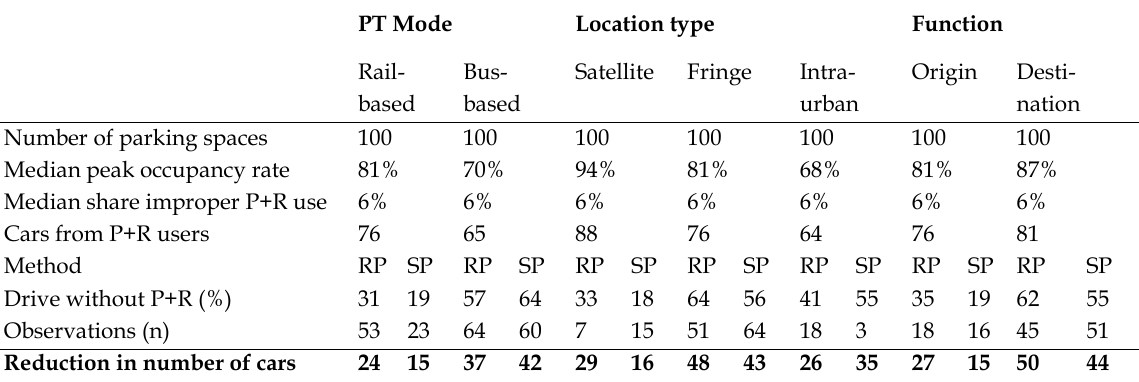
Table 4. Estimated reduction of cars entering the city for various types of P+R